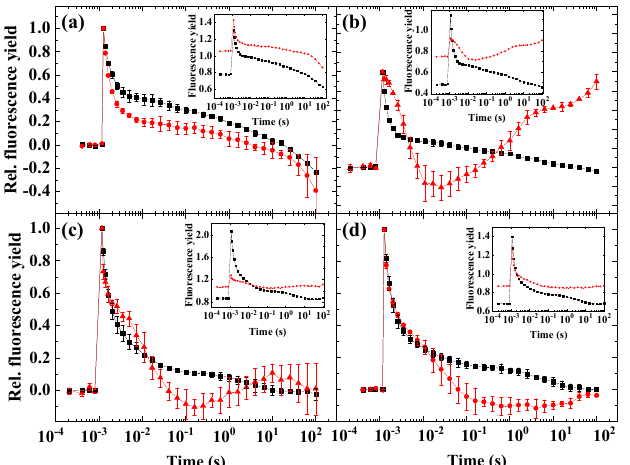
Figure 4. Flash-induced fluorescence relaxation under aerobic control (black) and HA + preillumi- nation (red). ( a ) Haematococcus pluvialis (green cells), ( b ) Dunaliella salina , ( c ) Chlorella sorokiniana , ( d ) Nannochloropsis limnetica. The HA + preillumination (red) was applied either under microaerobic condition ( a , b ) or under aerobic condition ( c , d ). The insets show the original curves, averaged over the three biological replicates, without normalization. Error bars represent the standard deviation of the mean of three biological replicates. Figure 5. Flash-induced fluorescence relaxation in red cells of H. pluvialis . ( a ) Control cells without inhibitor under aerobic (black) and microaerobic (red) conditions. ( b ) HA-treated cells under aero- bic conditions (red). ( c ) HA-treated cells under microaerobic conditions (red). The black traces in panels b and c show the aerobic untreated control as in panel a. Curves shown in panels a, b and c were double normalized (F 0 to 0 and F m(ST) , which represents maximal fluorescence after the flash to 1) to achieve the same initial amplitudes. Insets show the original traces, averaged over the three biological replicates, of the respective conditions without normalization. Error bars represent the standard deviation of the mean of three biological replicates. 2.5. The Effect of Inhibitors of Cyclic Electron Flow on the Fluorescence Wave Phenomenon It was important to clarify whether the wave phenomenon could be related to cyclic electron flow, mediated either by the NAD(P)H dehydrogenase (NDH-1/2) or the proton gradient regulatory (PGR5/PGRL1) pathways. To this end, various inhibitors specific to these complexes were applied. As H. pluvialis green cells and N. limnetica did not express the wave, these algae were not examined further. In D. salina , both polymyxin B and DPI partially blocked the fluorescence wave. An- timycin A was not found to be effective in blocking the wave phenomenon (Figure 6a). In C. sorokiniana , the most effective inhibitor was antimycin A, whereas polymyxin B or DPI was not effective (Figure 6b). In red cells of H. pluvialis , the wave was partially blocked by